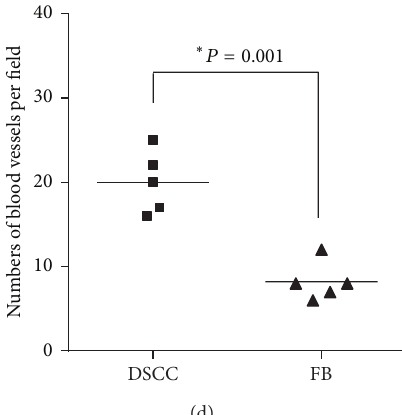
Figure 3: DSCC enhances angiogenesis. (a) Allografts are shown from groups 1 and 2 after 1 week of transplantation. We divided each graft image into 100 grids and counted the numbers of blood vessels in both groups. Higher numbers of blood vessels were observed in group 1 DSCC and islet allografts (left 18 ± 3 %) compared with group 2 FB and islet allografts (right 8 ± 2 %). Tissue sections of H&E staining are displayed from groups 1 (b) and 2 (c) one week after transplant. ((b) and (c)) Four images in each group consist of panoramic views of the graft. The numbers of big blood vessels ( > 50 𝜇 m diameter) were more in group 1 than in group 2 ( 4±2 % versus 1±1 %). Black arrows indicate the blood vessels. (d) Quantification of the blood vessels. Scale bar = 50 𝜇